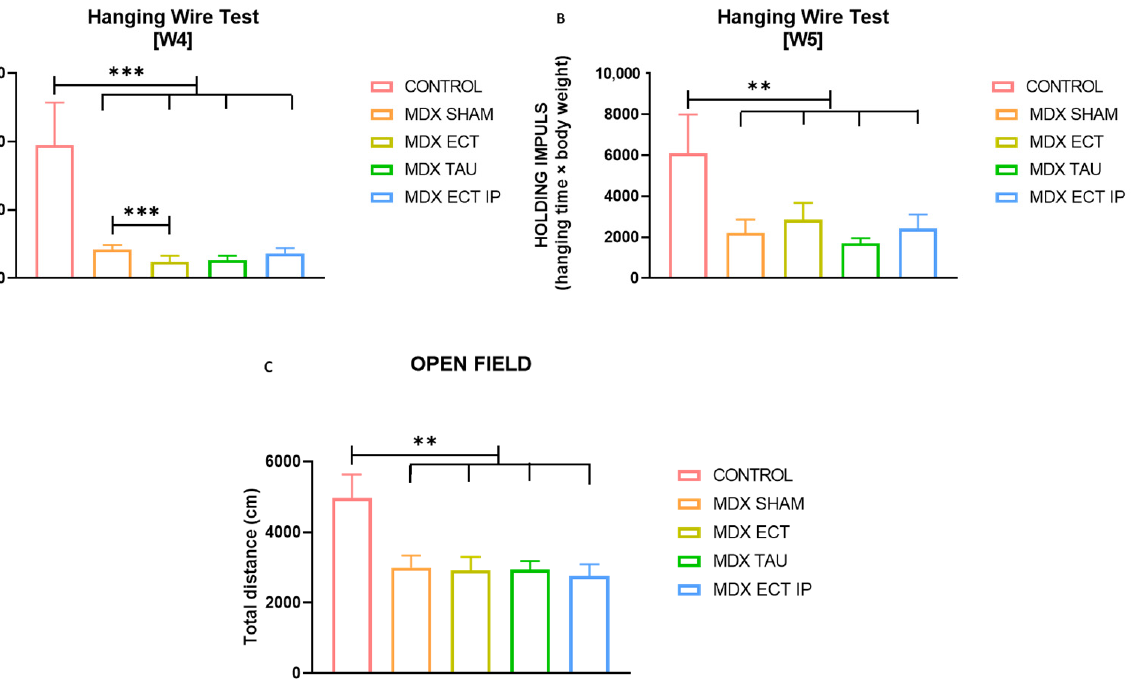
Figure 5. Results of functional tests in mice ( A ). Holding impulse (hanging time × body weight) of the four limb hanging wire in 4-week-old mice for evaluation of muscle strength. ( B ) Holding impulse of the four limb hanging wire in 5-week-old mice. ( C ) Total distance travelled in the open field test in 5-week-old mice for evaluation of locomotion. Data are presented as mean values ± SEM. Data of the hanging wire test were log-transformed to adhere to normality assumptions. A more detailed overview of statistical analysis is provided in Table S2. Statistical analysis was carried out to detect significant differences between sham-treated mdx mice and other groups or between control mice and other groups. Significant differences are annotated by ** ( p < 0.01) and *** ( p < 0.001). In the open field test, the total distance covered was significantly longer in control mice (4047.1 cm ± 251.8, p = 0.002) than in sham-treated mdx mice (2839.4 cm ± 333.6). Osmolyte treatment did not alter the total running distance in mdx . 2.7. Osmolyte-Treated Mice Exhibit Reduced Expression of Inflammatory Myopathy Markers A set of inflammatory muscle disease markers was examined using qPCR in the tibialis anterior of untreated, ectoine-treated and taurine-treated mdx mice (Figure 6) and normalized to the housekeeping gene GAPDH. mRNA expression of CCL2 was significantly lower in ectoine-treated ( p < 0.001) and taurine-treated ( p < 0.001) mdx mice compared to untreated mdx mice. Ectoine treatment, but not taurine treatment, downregulated mRNA levels of SPP1 in mdx mice ( p = 0.016), whereas taurine treatment downregulated expression of HSPA1A ( p < 0.001), TNF- α ( p < 0.029) and IL-1 β ( p = 0.004). We evaluated the presence of F4/F80+ cells, indicative for macrophages, and CCL2 by double immunofluorescent staining. We found no co-localization of the pro-inflammatory chemokine CCL2 with the macrophage marker (Supplement Figure